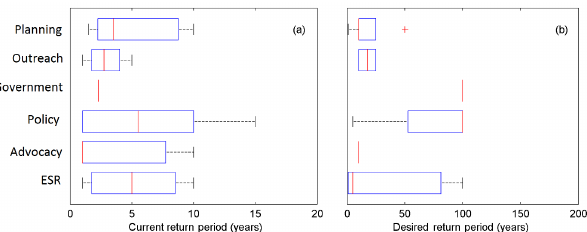
Figure 3. Estimated (a) current flood loss return period and (b) de- sired return period resulting from flood hazard mitigation efforts. Reports of desired frequency above 100 years are presented as 100- year for visualization. Red lines indicate the median.